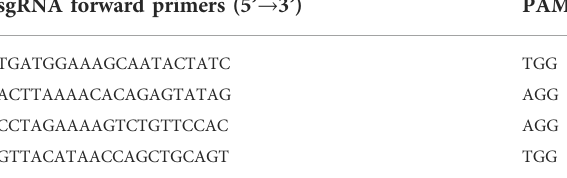
TABLE 2 Primer sequence information on small guide (sg)RNA and protospacer adjacent motif